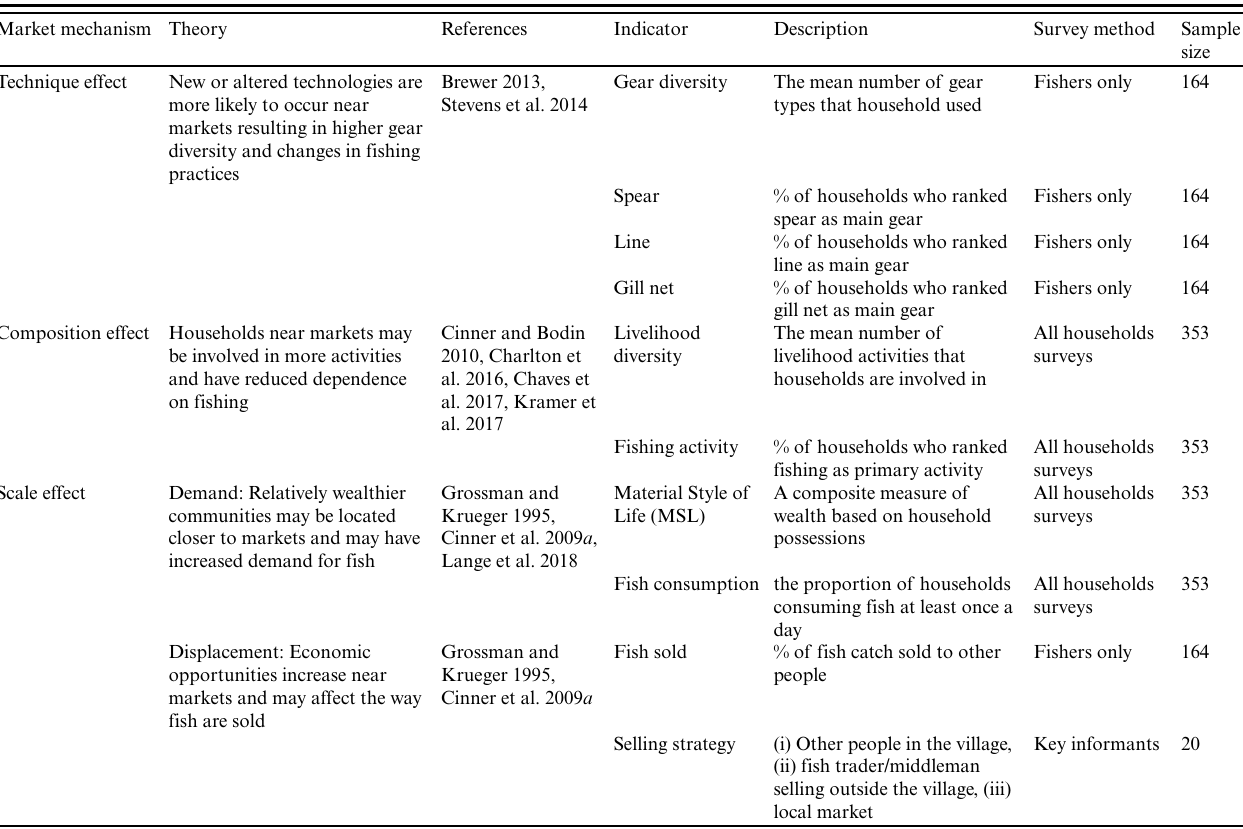
Table 2 . Description of the 10 indicators measured for the 10 coastal communities to investigate the association between socioeconomic characteristics and markets among coastal communities. Markets can affect communities through three causal pathways: (i) a technique effect, (ii) a composition effect, and (iii) a scale effect. Theory and references for each effect are also